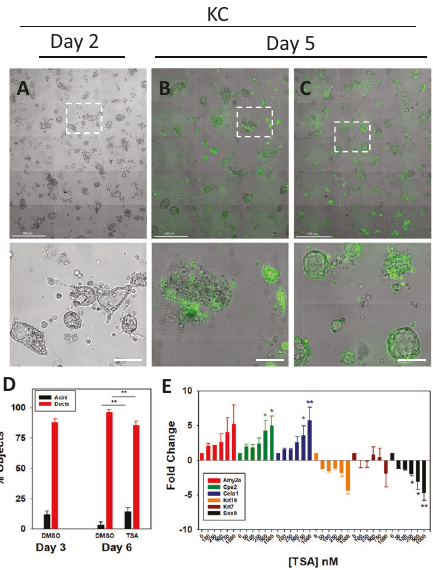
Fig. 5 Reversal of ADM by TSA in KC mouse acini. KC mouse pancreatic acini underwent ADM over 2 days of culture ( A ) and were then exposed to DMSO ( B ) or 1 µM TSA ( C ) for 2 additional days followed by Calcein AM viability staining. Shown are the high content images, with the enlarged sections (dashed lines) in the lower panels. Scale bars in the top images represent 500 µm and in the lower images 100 µm. D Acini and ducts were microscopically counted from four sections of the high content images. E Expression of acinar and ductal genes from TSA treated KC mouse pancreatic organoids following the identical treatment as in ( A – C ). Data are presented as fold-change normalized to 18S rRNA and relative to the untreated control. Mean ± SD from duplicate experiments. * P < 0.05; ** P <